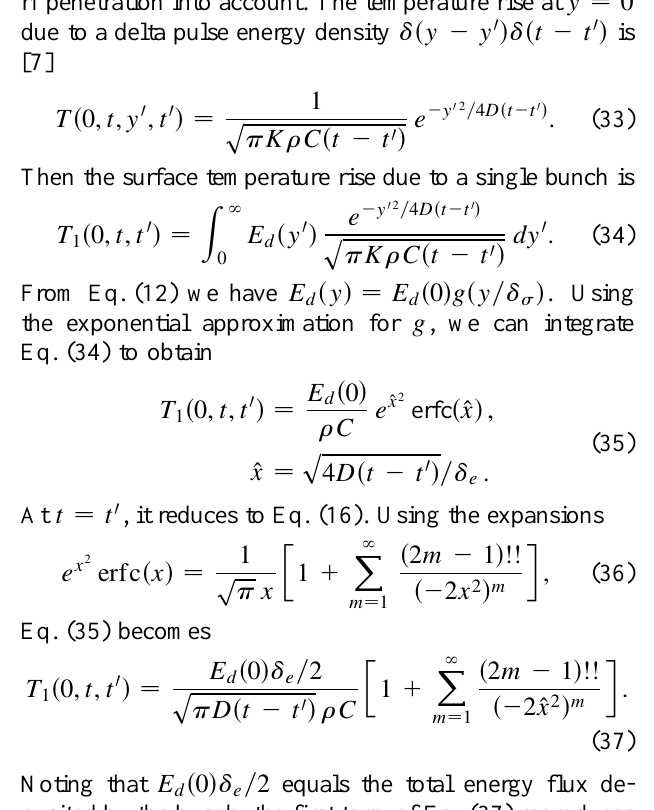
(cid:1) 66.5 ± C. It is N